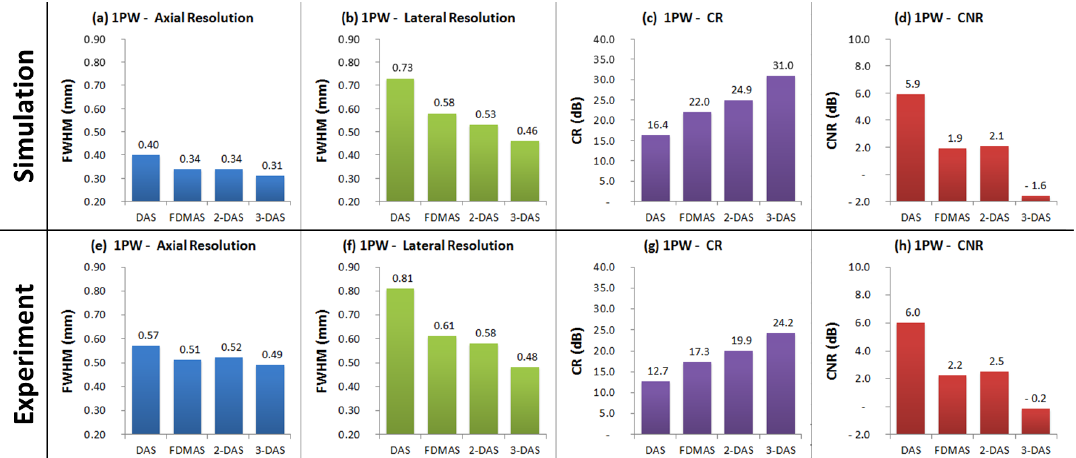
Figure 4. Performances obtained with DAS, FDMAS, 2-DAS, and 3-DAS beamformers, using a single plane wave in simulations ( a – d ) and experiments ( e – h ). The results obtained are given for axial resolution ( a , e ), lateral resolution ( b , f ), contrast ratio ( c , g ), and contrast-to-noise ratio ( d , h